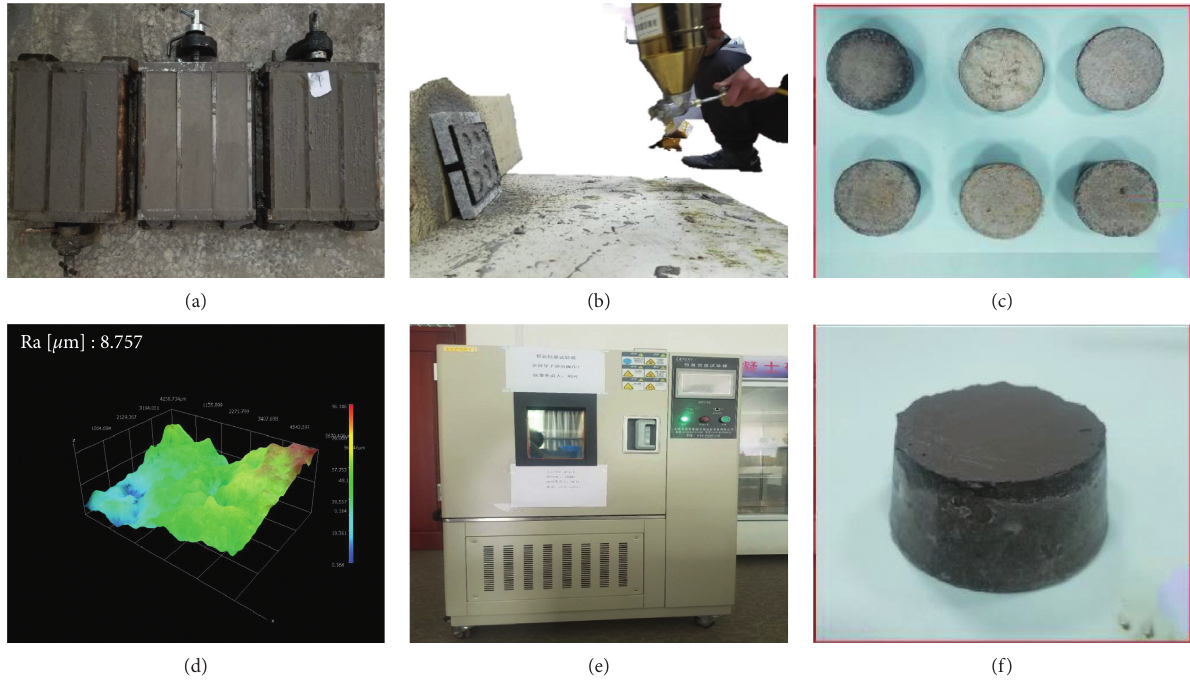
Figure 2: Sample preparation process. (a) Experimental rectangular test piece. (b) Bond test piece making. (c) Permeable substrate. (d) Surface roughness of bonded substrates. (e) Test piece maintenance box. (f) Penetration test block.